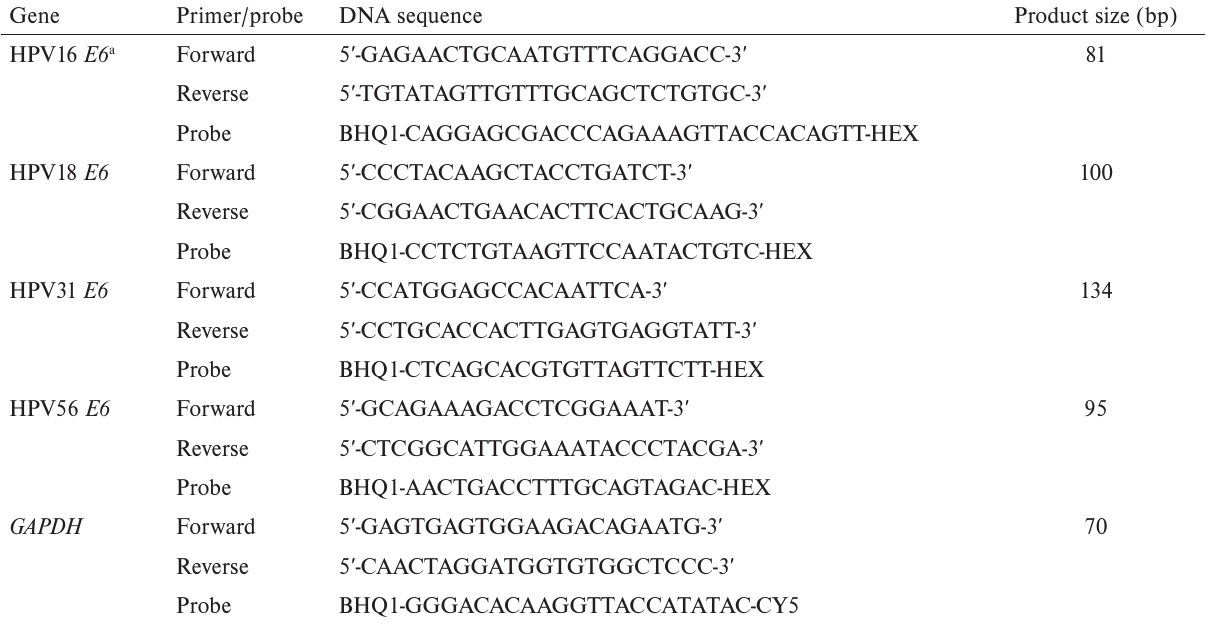
Table 2. Characteristics of HPV16, 18, 31, and 56 E6 and GAPDH primers/probes.